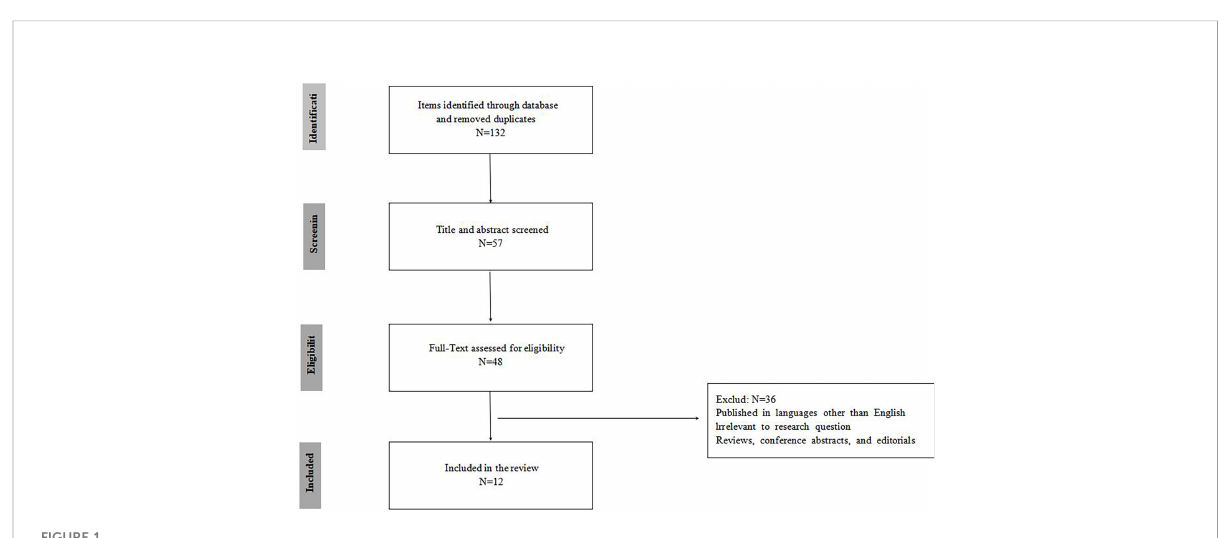
FIGURE 1 PRISMA fl owchart of included